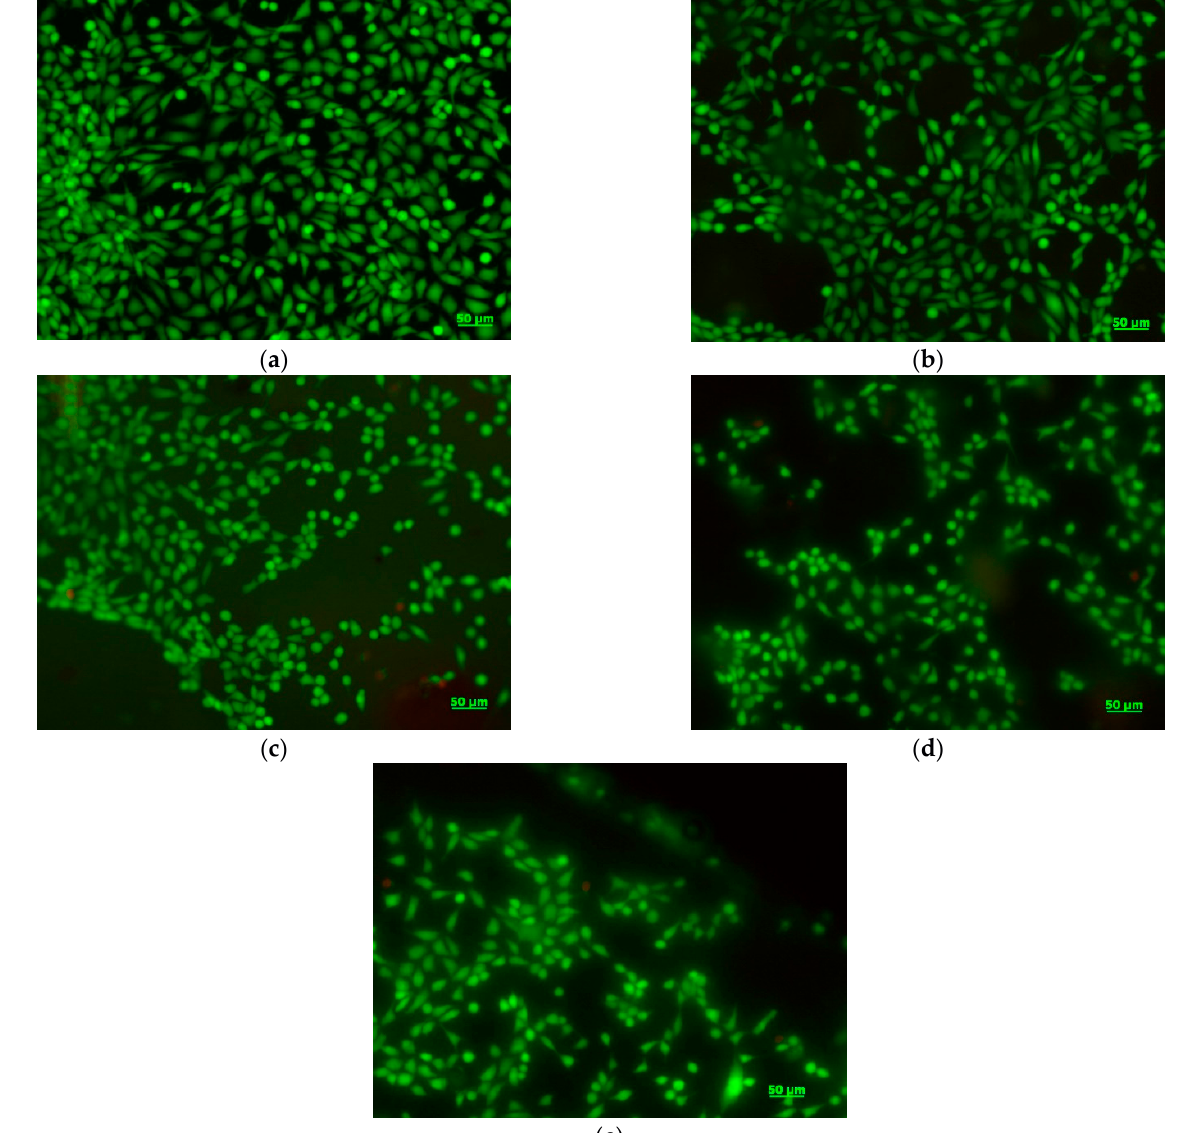
Figure 10. Fluorescent images of NCTC live (green) and dead (red) cells, untreated ( a ) and treated with PLA/CO ( b ), PLA/S ( c ), PLA/CO/S ( d ), and PLA/CO/S/I.31PS ( e ) for 72 h. Scale bar = 50 μ m.